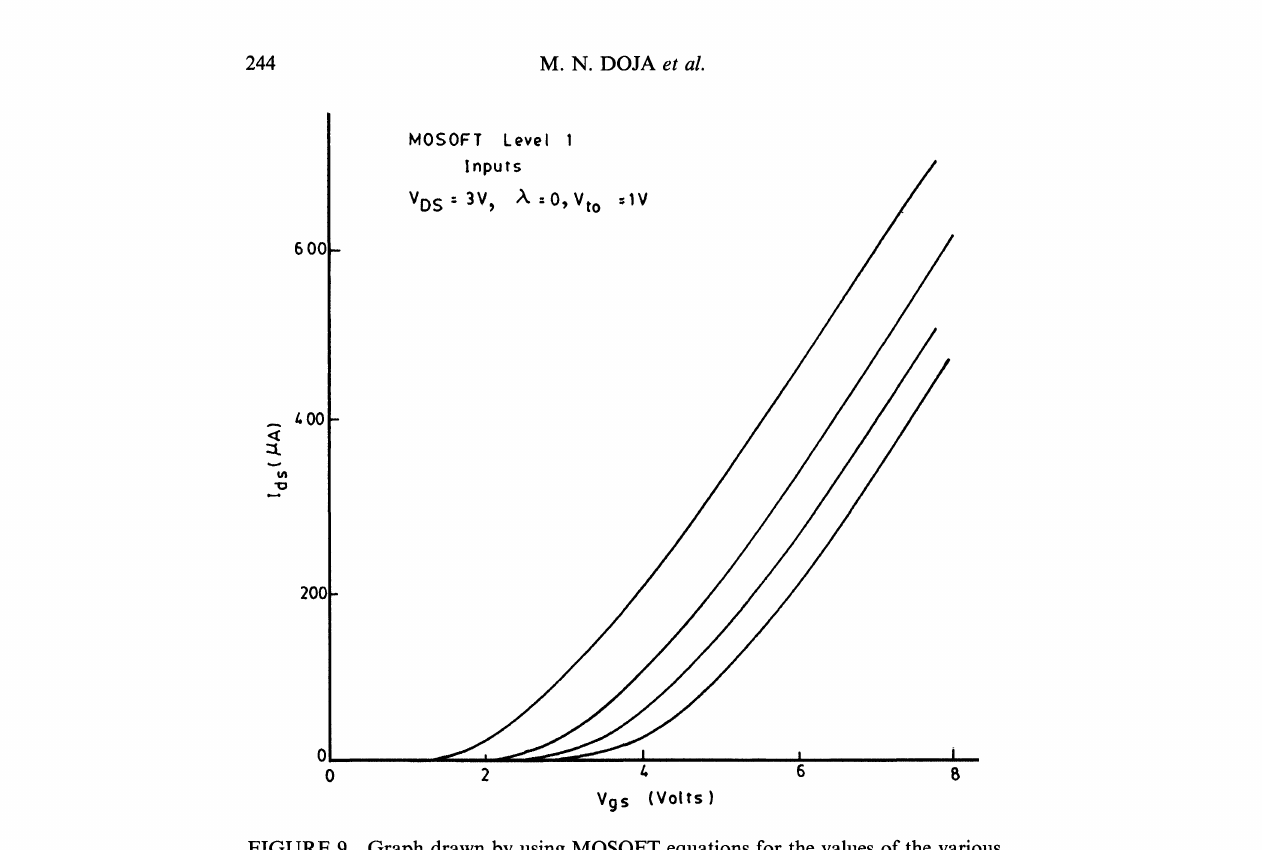
FIGURE 9 Graph drawn by using MOSOFT equations for the values of the various parameters as